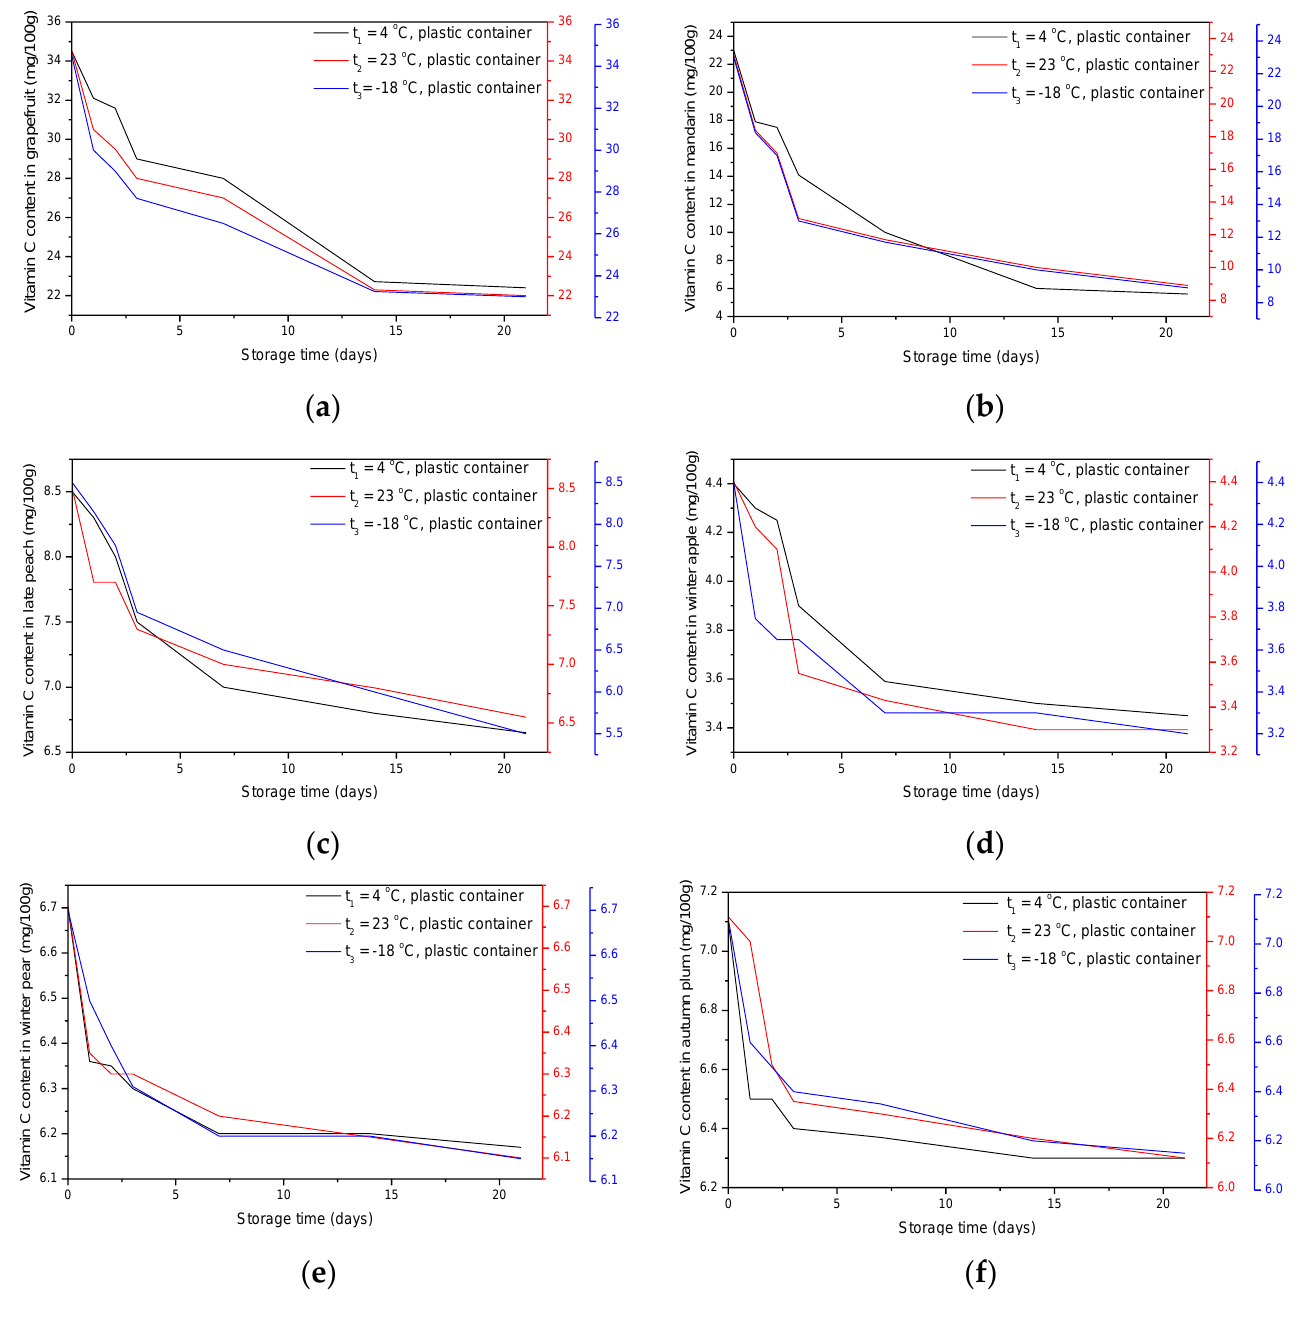
Table 2. The correlation coefficients between the amount of vitamin C (mg/100 g) present in fruit juices kept in glass and plastic containers at various temperatures and for varying lengths of time. Juices Glass Containers